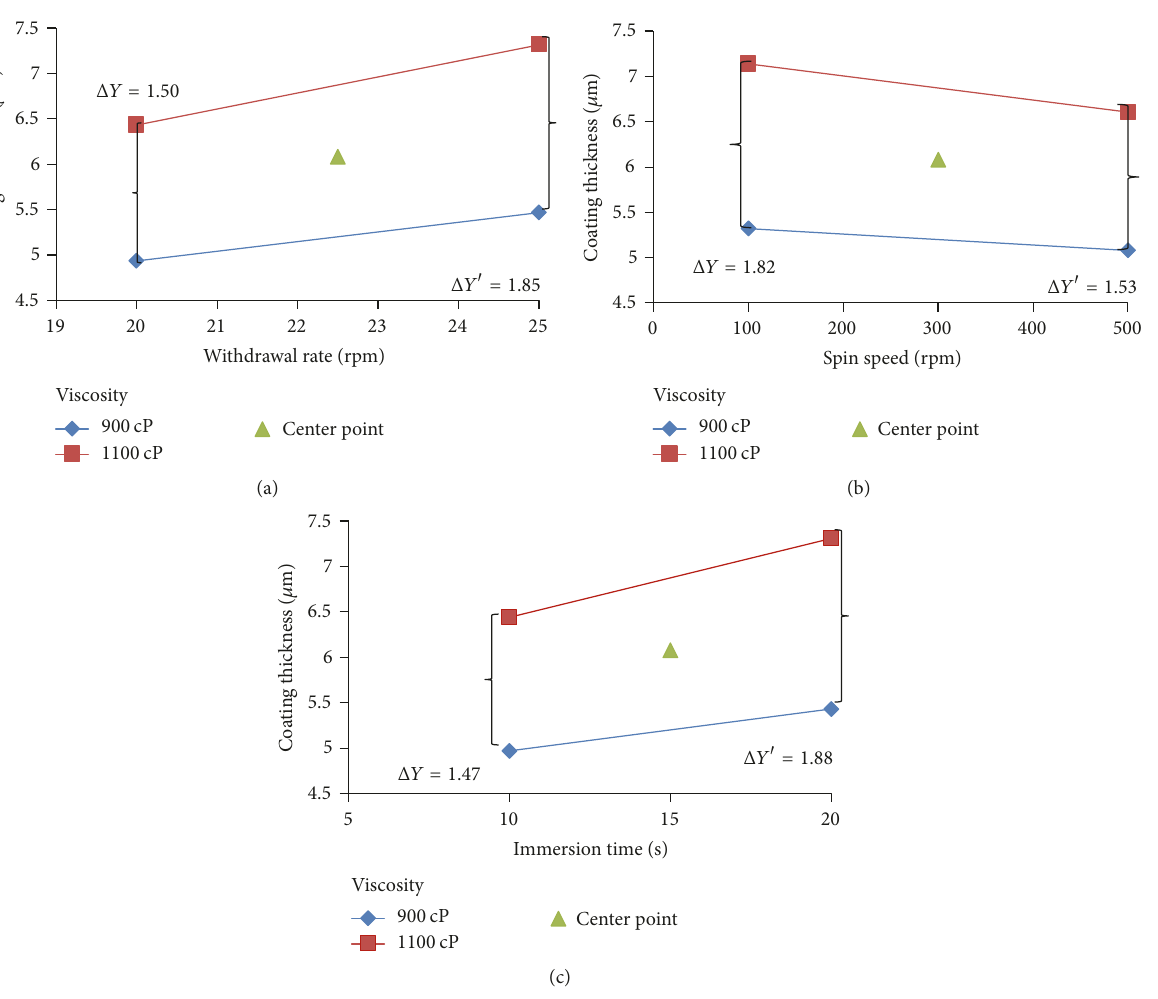
Figure 8: Interaction effect plots of viscosity with (a) withdrawal velocity, (b) spin speed, and (c) immersion time for coating